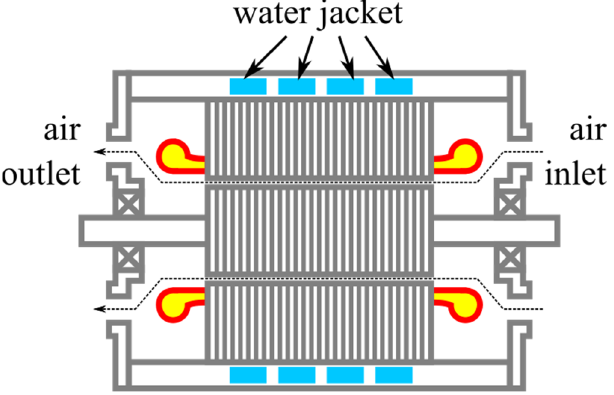
Figure 23. Hybrid cooling method (forced-air + water jacket) [112].